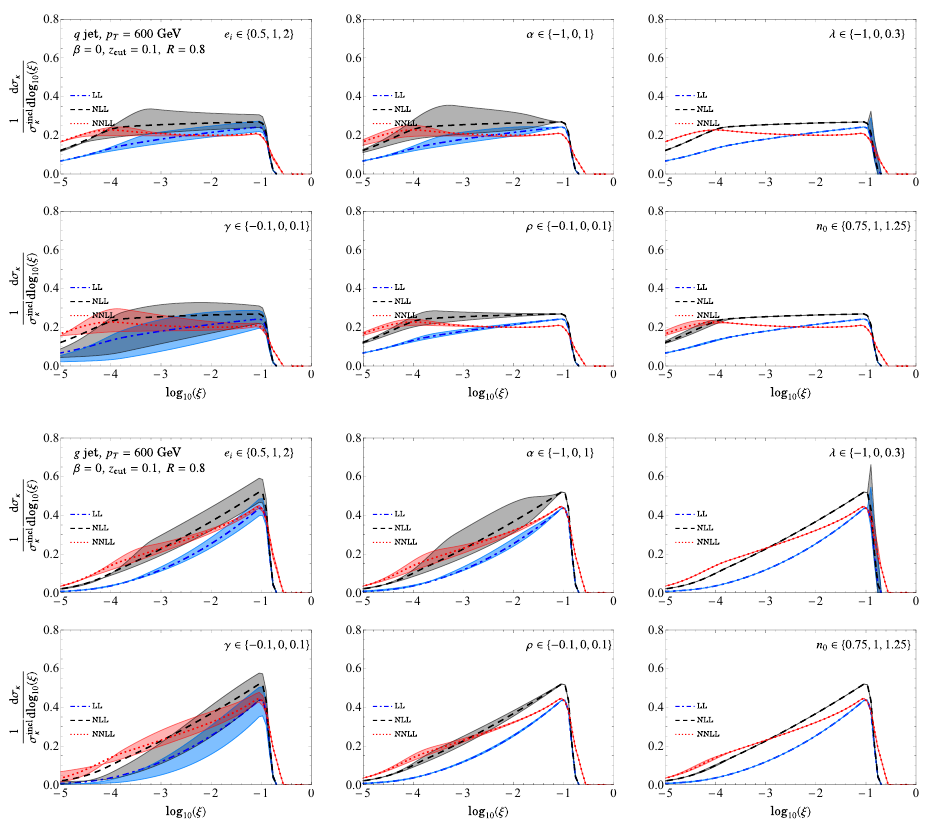
Figure 17 . Variations for each of the six different profile-variation parameters individually, for quark and gluon jets at p = 600 GeV, with β = 0 . T